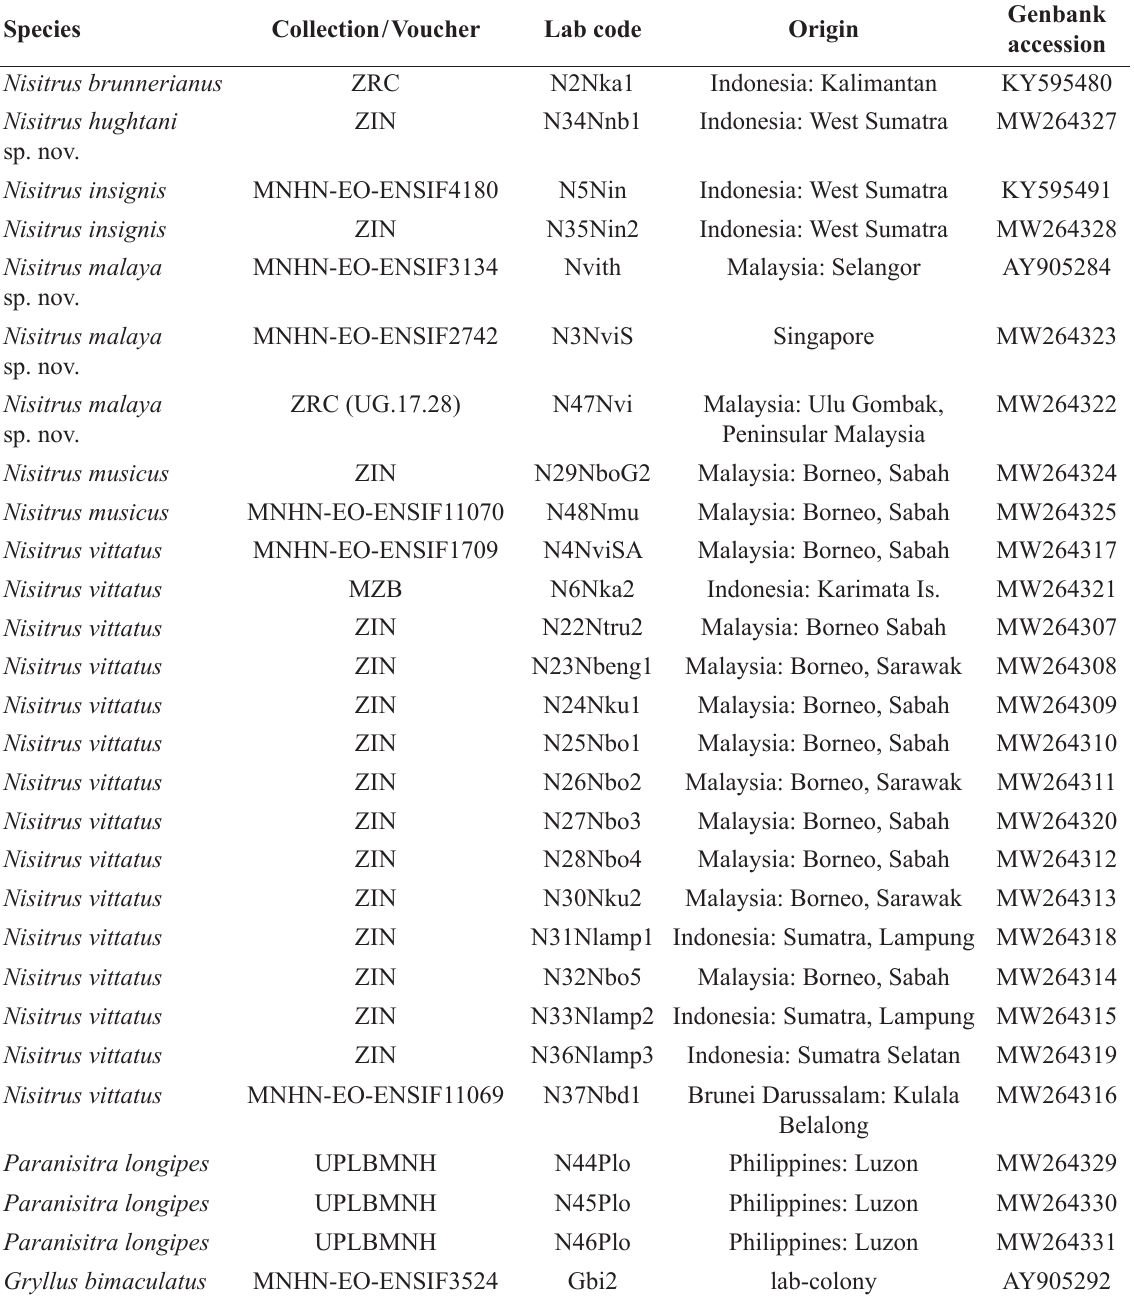
Table 1. List of specimens and their details used to construct the 12S gene